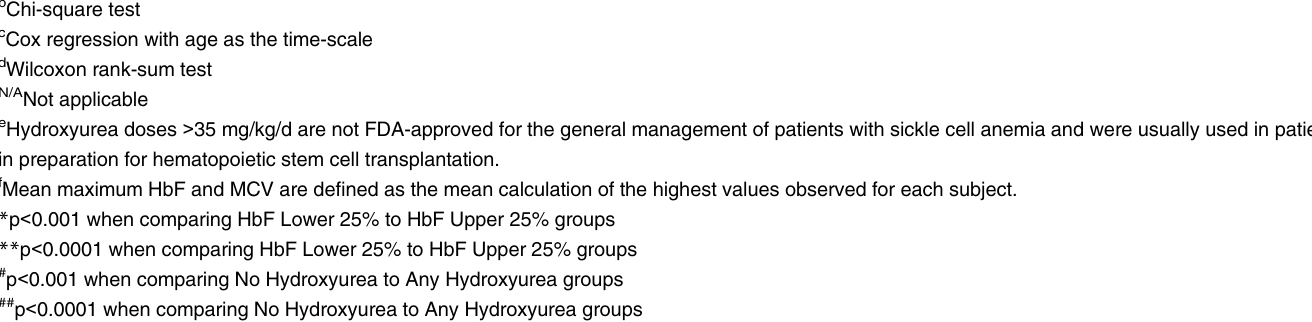
versus had never taken hydroxyurea. At the first visit, total bilirubin was greater (3.3 versus 2.8mg/dL, p = 0.018), creatinine lower (0.8 versus 1.2mg/dL, p = 0.0015), and TRV higher (2.6 versus 2.5m/s, p = 0.025) in patients taking hydroxyurea (Table 5). Conversely, at the last visit, there were no significant differences in markers of organ function in patients taking versus not taking hydroxyurea. Therefore, there was no apparent difference in organ dysfunction over time based solely on whether patients had received hydroxyurea. Subjects were then divided into groups based on whether their dose was below (0 – 15 mg/kg/day) versus at or above the recommended dose (15 – 35 mg/kg/day). At the first visit, creatinine was lower in patients who took the recommended dose (0.7 versus 1.2mg/dL, p = 0.002). However, there were no